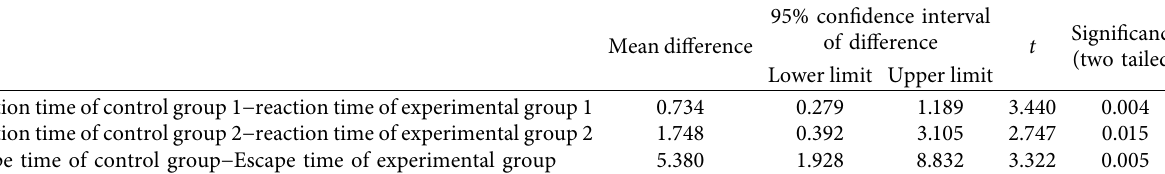
Table 5: Outputs of sample t -tests of three groups.